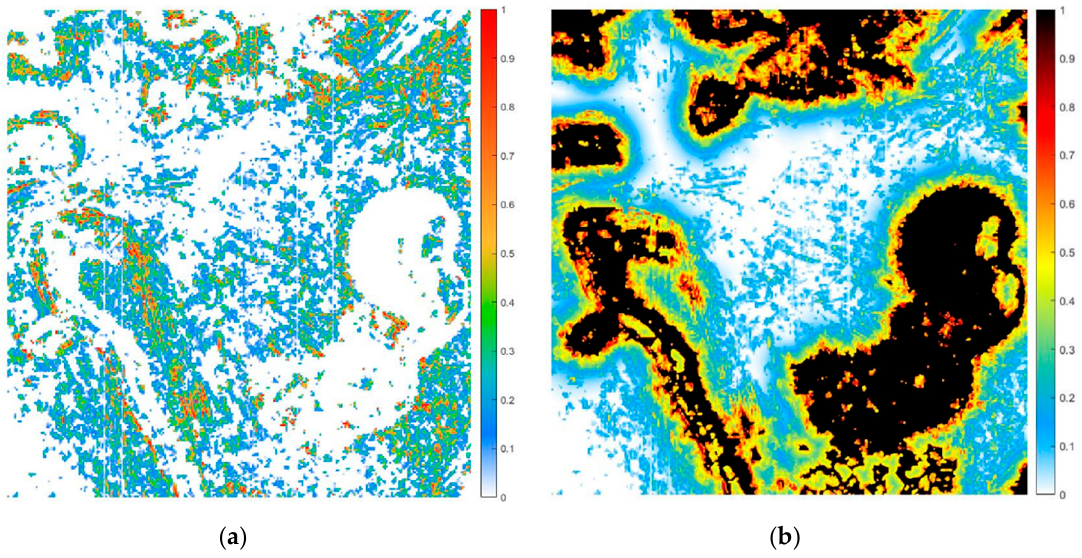
Figure 8. Schematic diagram of Roughness Cost Map and C-MAP. ( a ) is the Roughness Cost Map without obstacle; ( b ) is the C-MAP. The color distribution represents the traversable of the road surface. Black represents obstacle area.